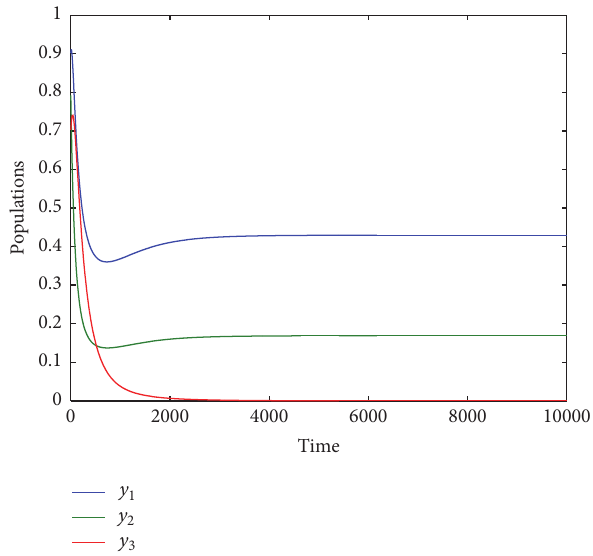
Figure 5: Time series of system (3) approaches asymptotically to the predator free equilibrium point 𝐸 1 = (0.42, 0.16, 0) for 𝑎 2 = 0.9 and = 0.7 with other parameters given by 𝑏 4